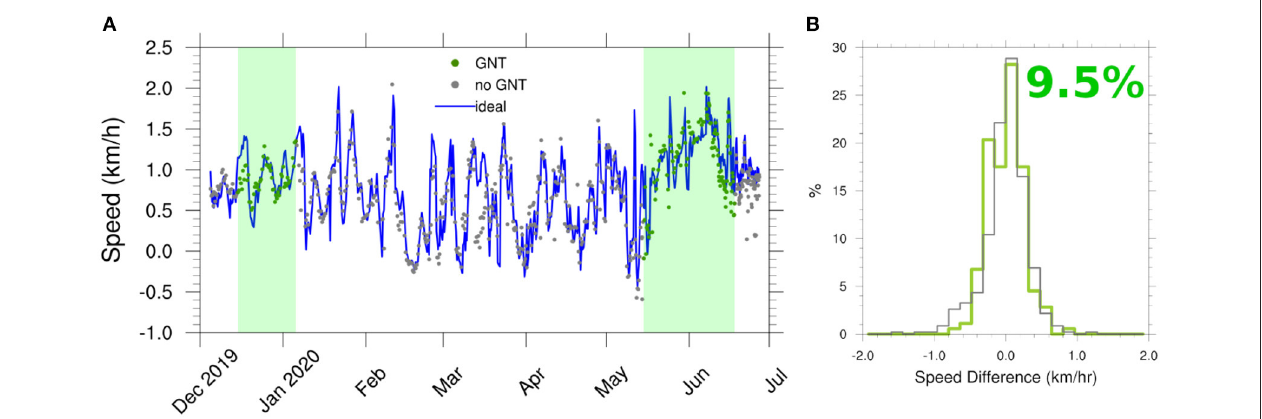
FIGURE 8 | Results of OceanGNS tests for the Labrador Sea mission. (A) Shows the glider speed (dots) toward its intended waypoint (destination) for every dive segment calculated from GPS positions. The shaded period is the time when OceanGNS was used. The blue line is the calculated ideal speed the glider could achieve based on the constant value of 0.27 m/s and the dead reckoned currents estimated by the glider (Equation 7). (B) Histogram of ideal vs. achieved glider speed toward the target. The residuals of the ideal speed vs. the actual speed toward the waypoint shows that during the OceanGNS test period, the glider speed exceeded the ideal value by an average of almost